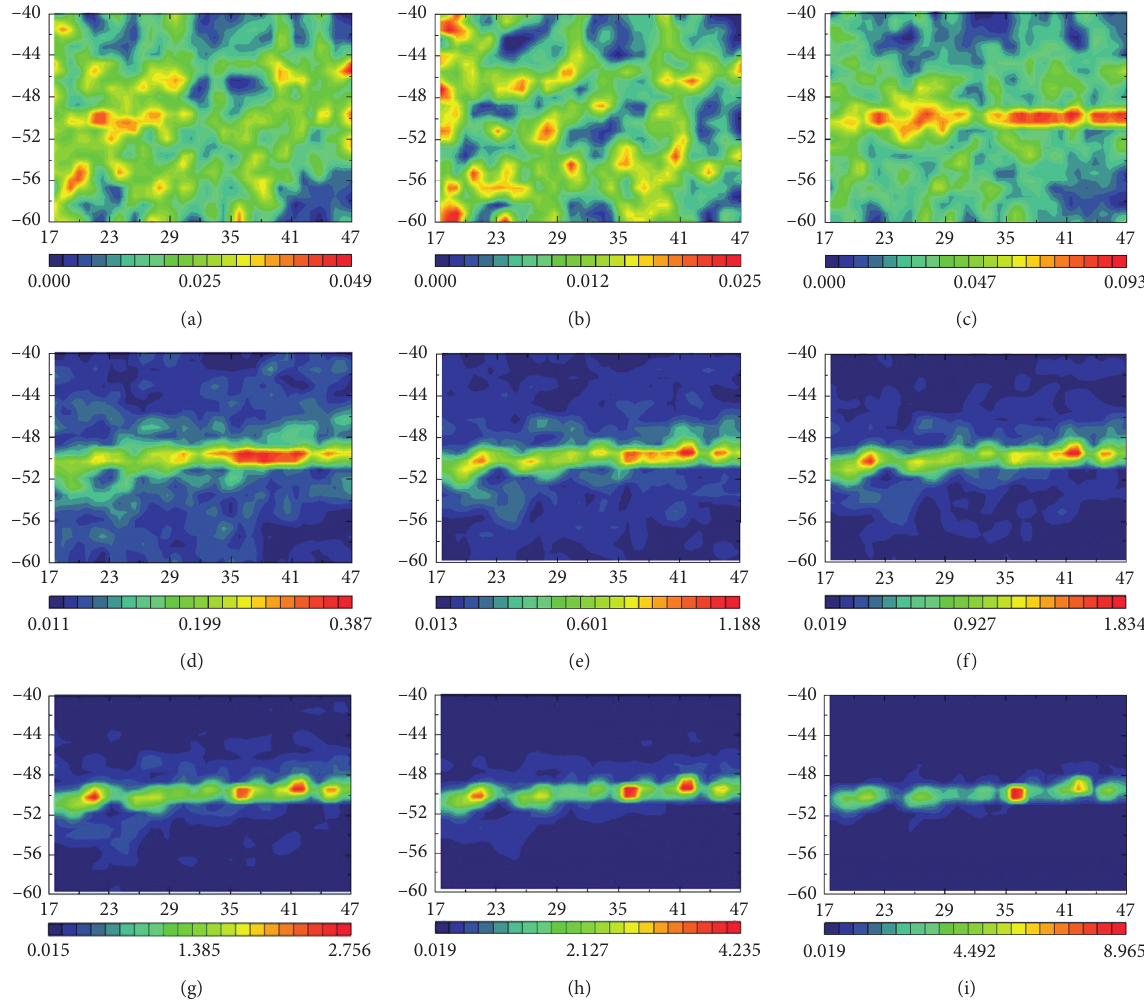
Figure 6: Distribution of maximum shear strain field in calcareous sand (note: the units of horizontal and vertical coordinates in the figure are pixel numbers). (a) S � 0.2mm, (b) S � 0.6mm, (c) S � 1.0mm, (d) S � 2.0 mm, (e) S � 4.0mm, (f) S � 5.0mm, (g) S � 6.0 mm, (h) S � 7.0mm, and (i) S � 8.4mm.